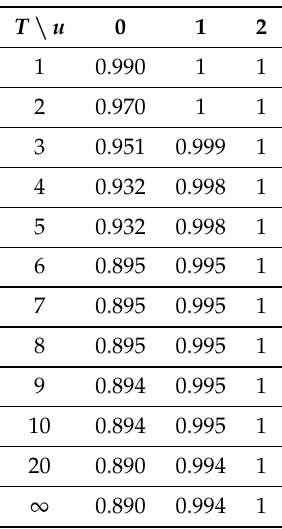
Table 5. Values of survival probabilities for the model of Example 1.